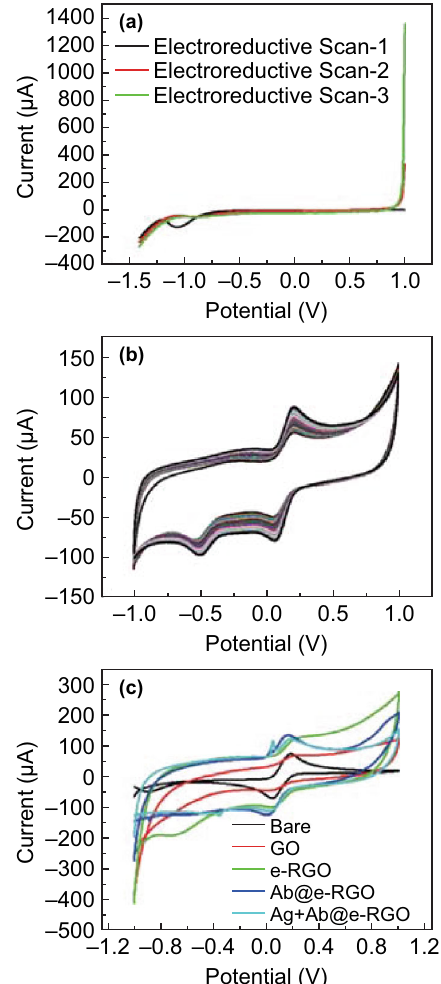
Fig. 3 a LSV-based characterization of electroreduction steps of GO to e-RGO. b Electrodeposition of graphene by CV. c The CV curves at different stages of SPE